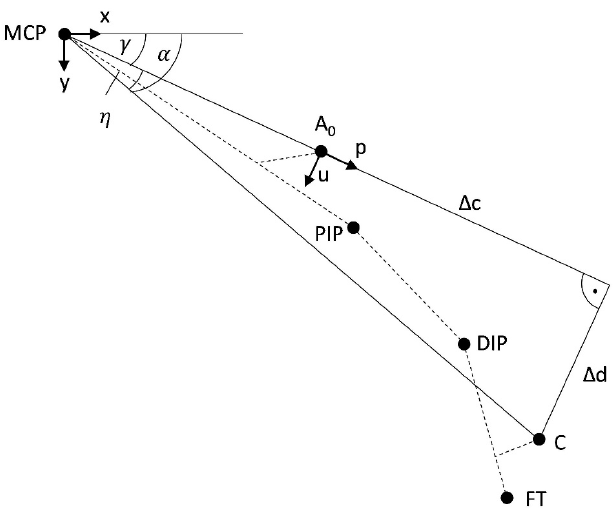
Figure 6. A scheme for determining C coordinates in the second linkage mechanism by considering the known PIP (proximal interphalangeal joint), DIP (distal interphalangeal joint), and FT (fingertip) coordinates. The u-axis is perpendicular to the p-axis with direction from top to bottom. ∆ c is the distance between A0 and C along the p-axis, and ∆ d is the distance between A0 and C along the u-axis. Figure 4. The displacement of the PIP point and A0 is shown in Figure 7 where ϕ is the angle between the horizontal axis and line through PIP, while ψ is the angle of MCP from A0 to PIP. The distance between MCP and A0 is l A0 , and the distance between MCP and PIP is l PIP . Parameters a and